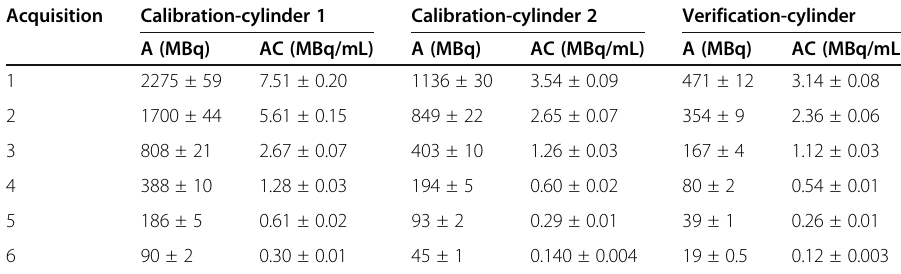
Table 1 Activities and activity concentrations in the cylinders used for calibration and verification